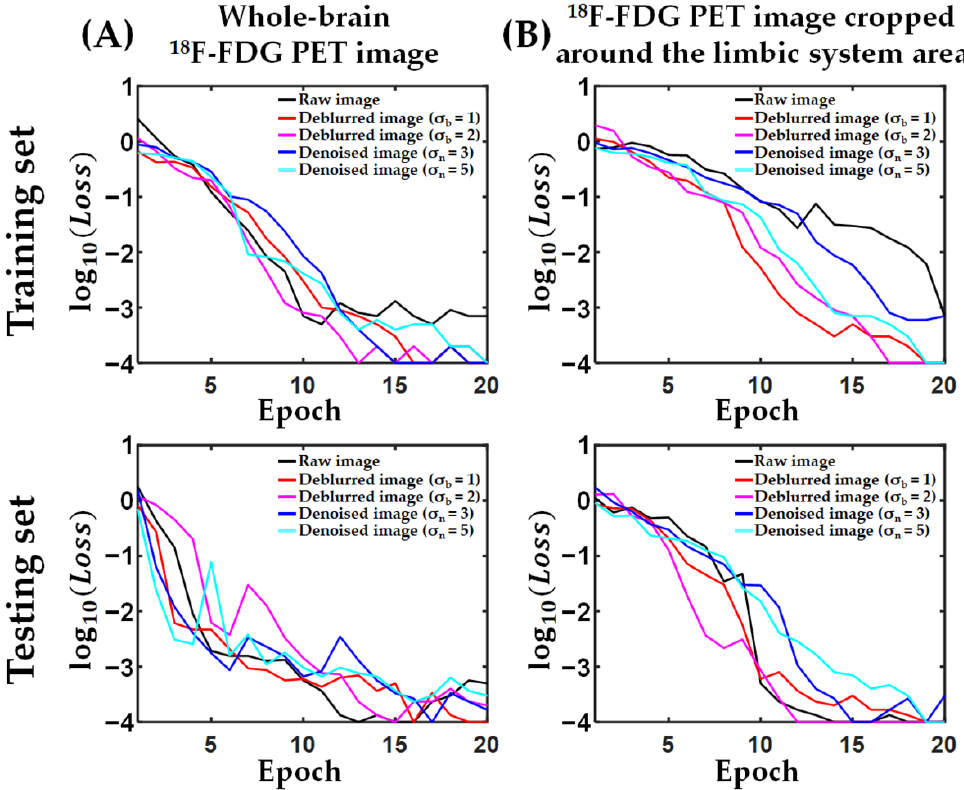
Figure 1. Convergence curves of a 3D deep-convolutional neural network trained using raw, deblurred, or denoised whole-brain 18 F-fluorodeoxyglucose positron emission tomography ( 18 F-FDG PET) images ( A ) and 18 F-FDG PET images cropped around the limbic system area ( B ). A semi-logarithmic line plot has a logarithmic scale of loss on the y -axis. Table 3. Performance comparison of an individual classification model trained using raw, denoised, or deblurred 18 F-FDG PET images that were cropped around the limbic system area in order to classify Alzheimer’s disease and cognitively normal conditions.